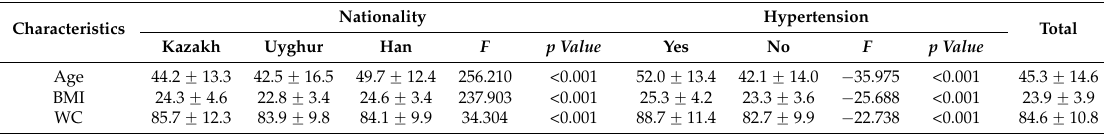
Table 1. Age, BMI, WC and WHR of population.